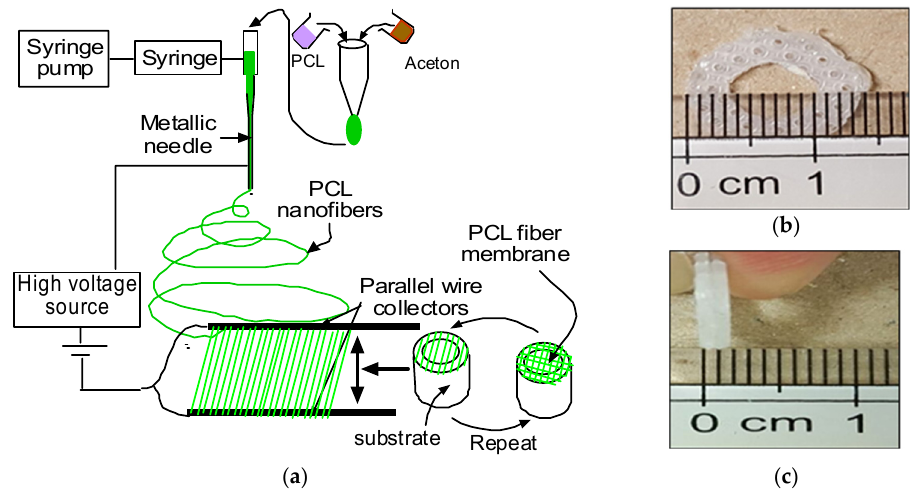
Figure 2. ( a ) Schematic representation of production of parallel nanofibers and collection of PCL fiber membrane on a round shape collector. Inset picture shows the PCL fiber on the collector. A plastic ring was used as an anchor for mechanical tension development. ( b ) Front view and ( c ) side view.